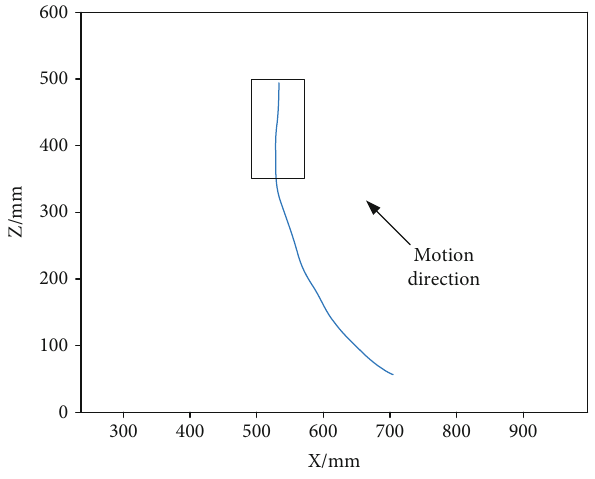
Figure 4: Projection of motion trajectory on XZ